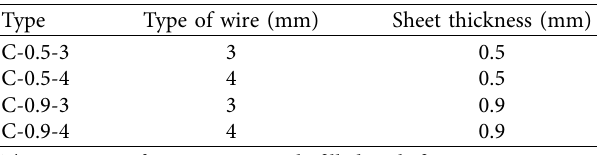
Table 2: The notation of composite panels filled with foamed concrete.